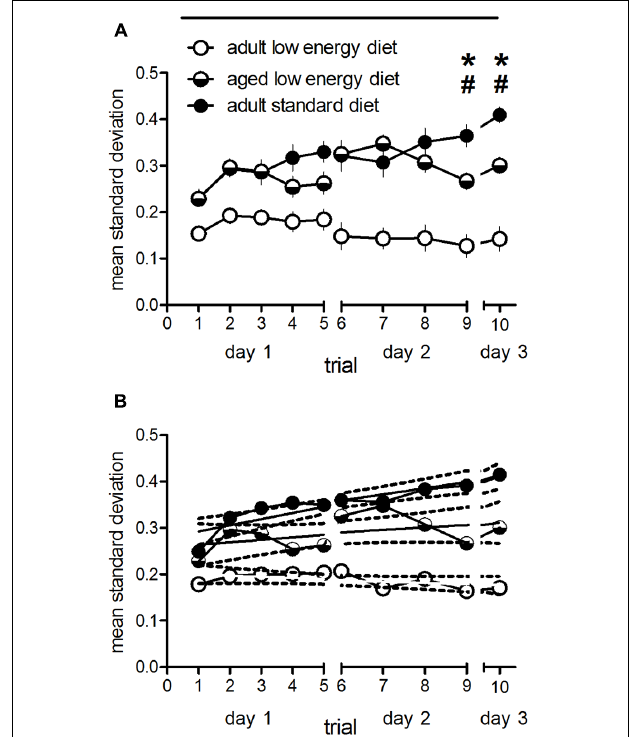
FIGURE 2 | Standard deviations of the reference memory indices of subdivisions ( n = 10, each, n = 7 for one sample of aged low energy diet rats; (A) and linear regression with 95% confidence intervals (broken lines) of the mean standard deviations (B) of adult animals fed with standard and adult and aged rats under low energy diet. Horizontal bars indicate statistically significant differences between groups over the entire training. Asterisks and hash marks indicate trial specific differences between adult standard and low energy diet fed rats and adult standard and aged low energy diet fed rats, respectively. Given are the means and standard errors of